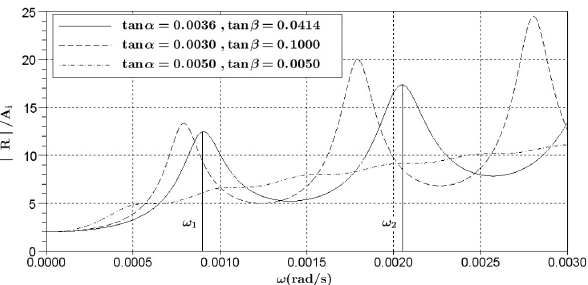
Fig. 2. Run-up amplifications for three sets of bottom slopes, h 0 = 2500m, h 1 =